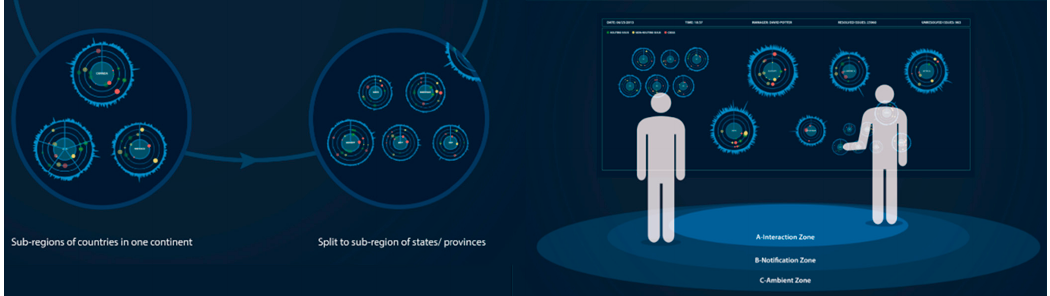
Figure 7. Physical movement and visualization transformation from the Notification Zone to the Interaction Zone.